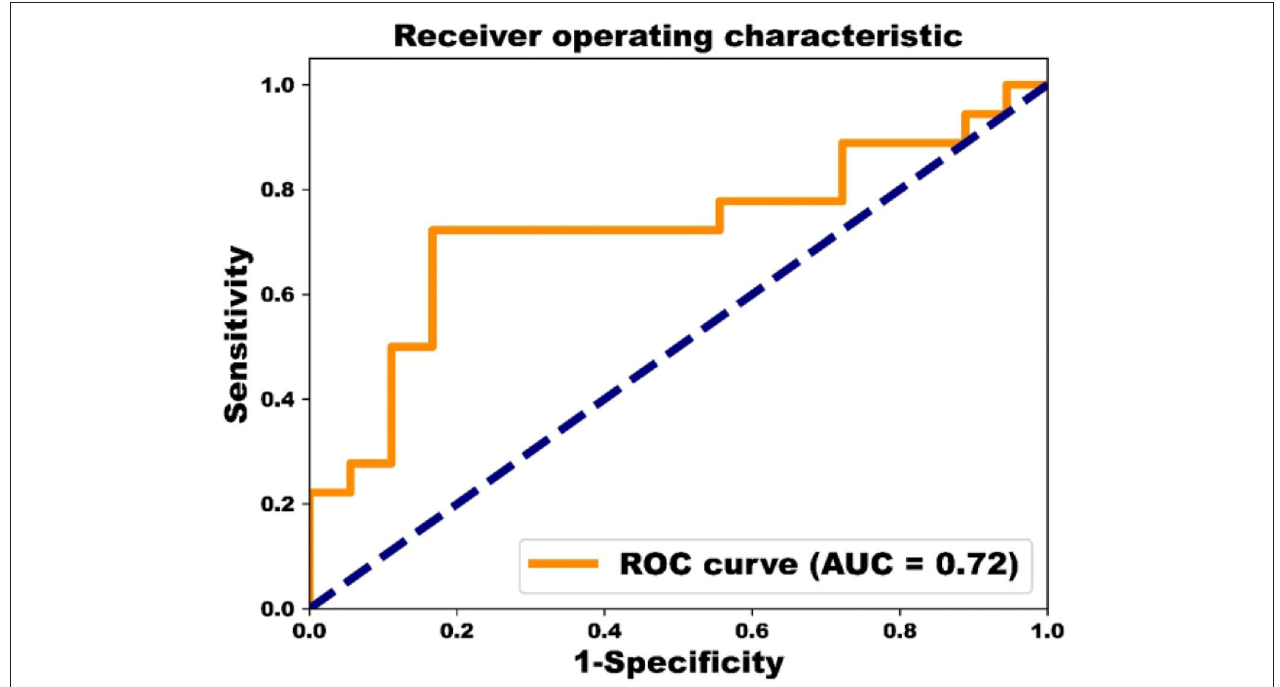
FIGURE 3 | ROC curve analysis with AUC